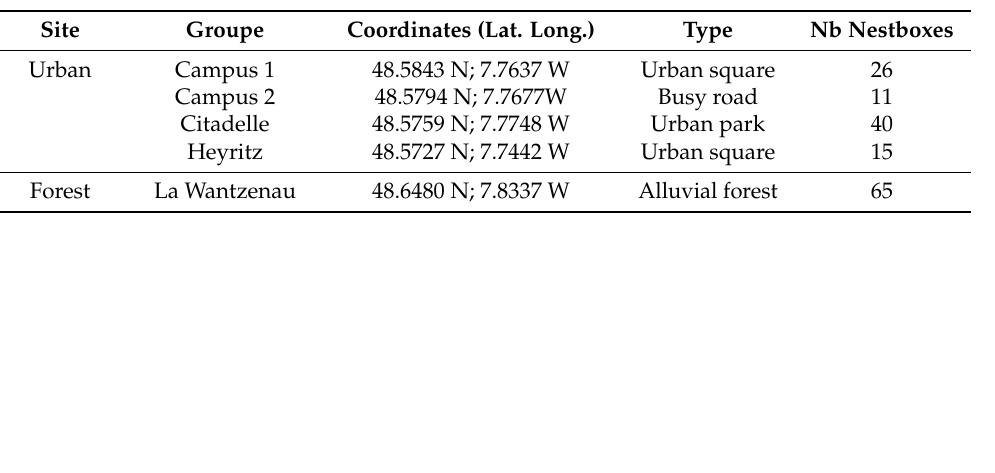
Table A1. Geographical Coordinates of the Nest Box Groups on each